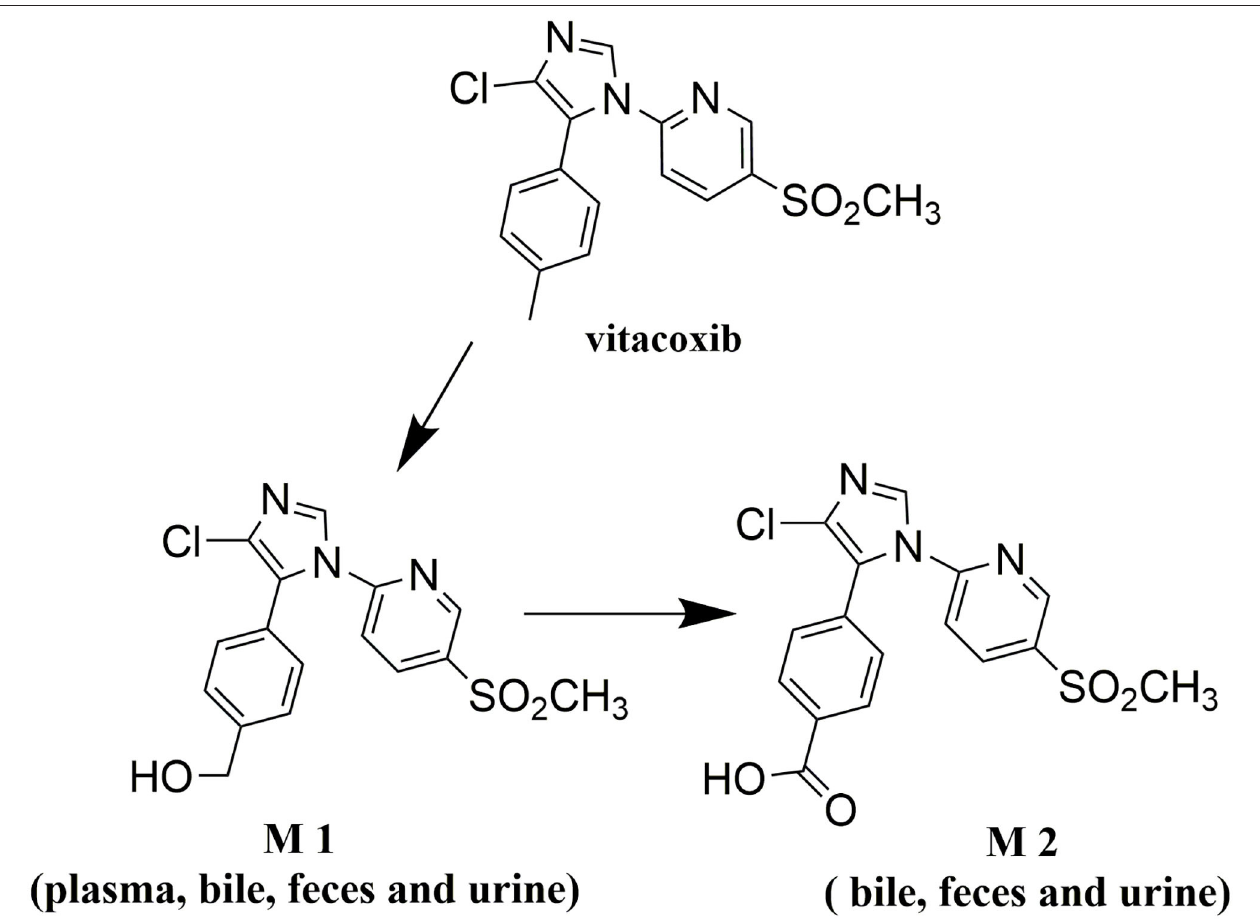
FIGURE 1 | The proposed metabolic pathway for vitacoxib in